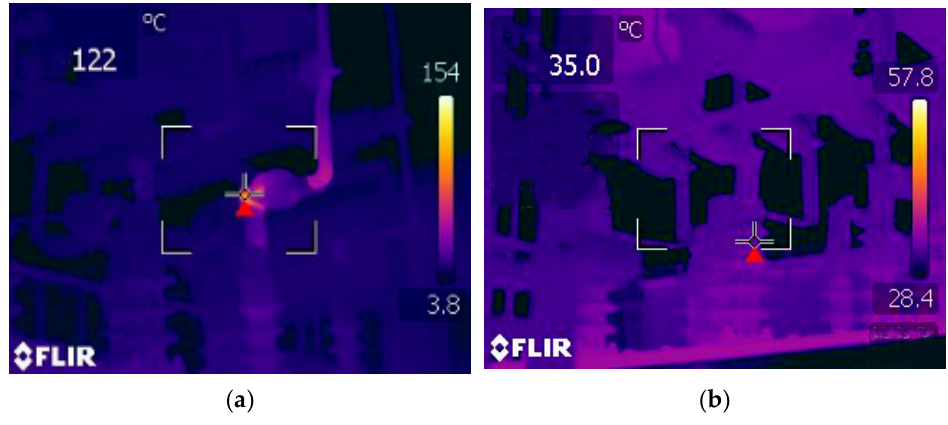
Figure 10. Infrared temperature measurement on running equipment. ( a ) before brush plating; ( b ) after brush plating.